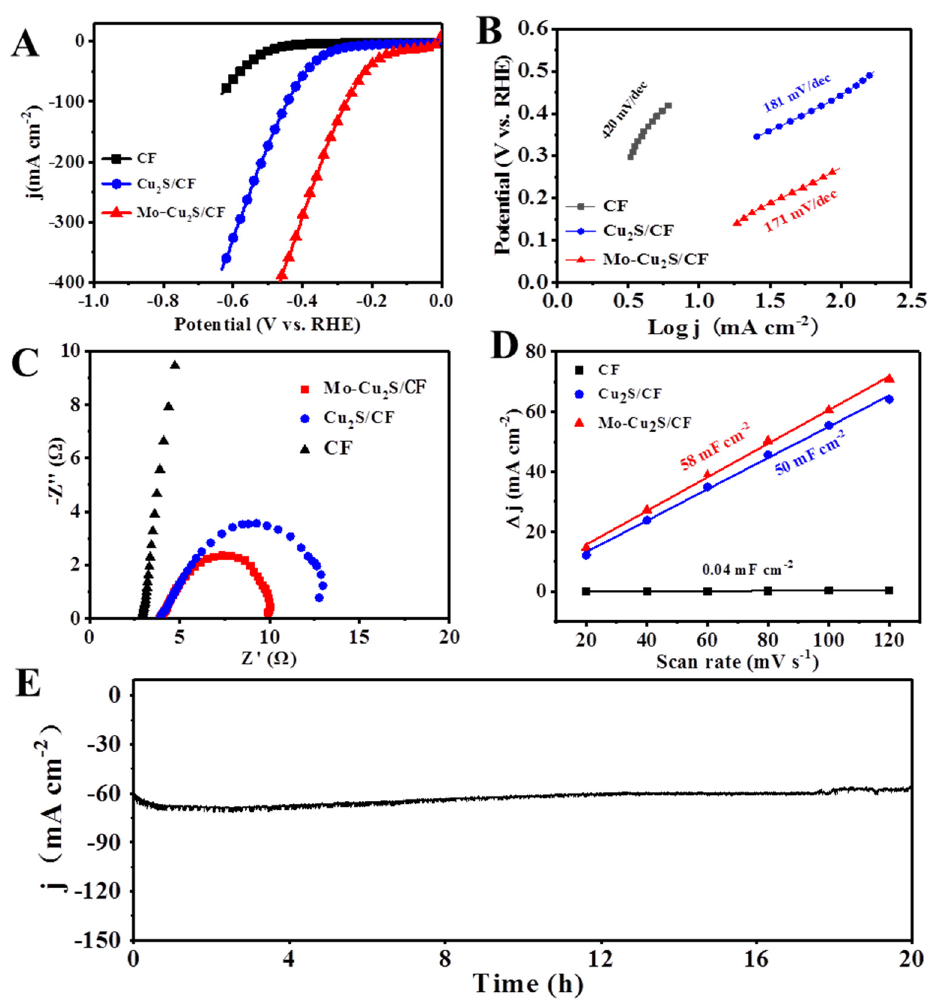
Figure 5. ( A ) LSV polarization curves of Mo-Cu 2 S/CF, Cu 2 S/CF and CF in1.0 M KOH at scan rate of 5 mVs − 1 ; ( B ) Tafel curves; ( C ) EIS Nyquist plots; ( D ) C dl plots for the estimation of the ECSA; ( E ) chronoamperometric curve (I-t) obtained for HER with Mo-Cu 2 S/CF at the current density of 60 mA cm − 2 in 1 M KOH.